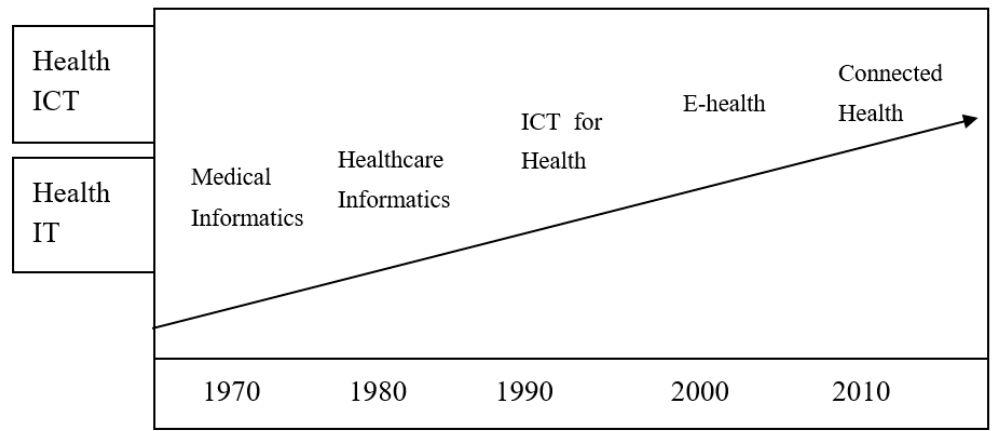
Figure 3. The evolution of names, from “medical informatics” to “connected health” (Rossi Mori et al., 2007).